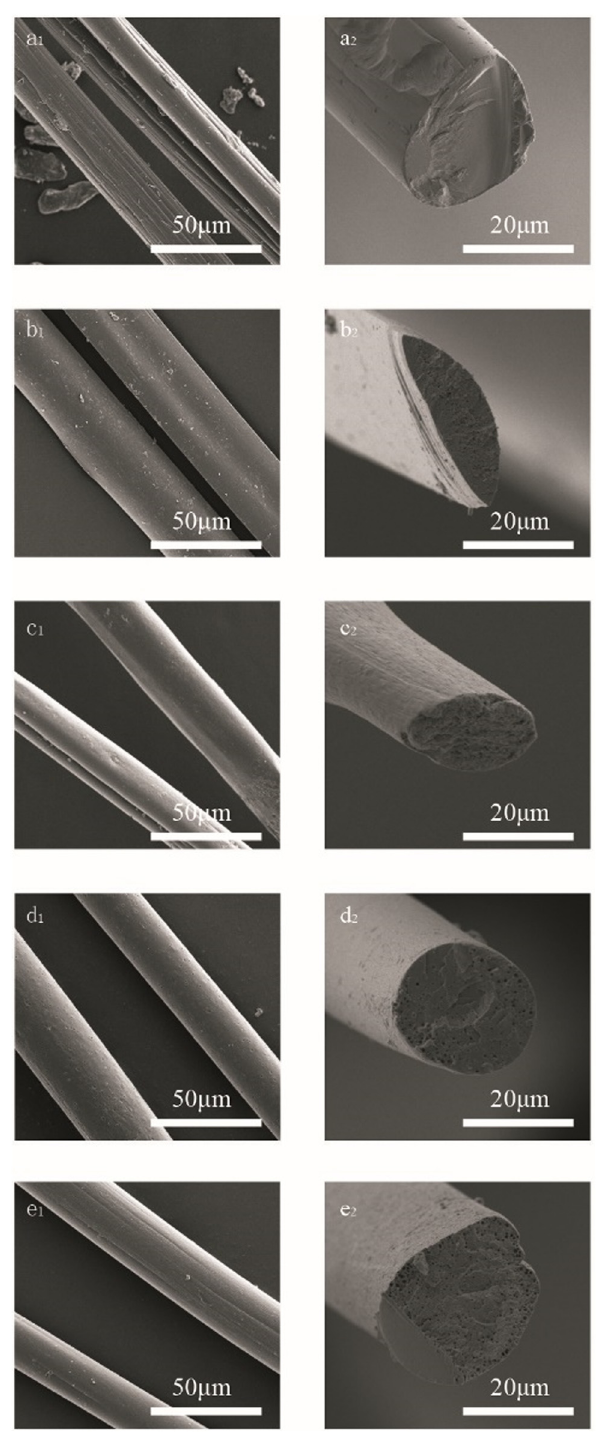
Figure 8: SEM images of the NF ( a 1 , a 2 ) , SC fi ber ( b 1 , b 2 ) , STC fi ber ( c ) , MC fi ber ( d ) , and MTC fi ber ( e 1 , c 2 1 , d 2 and cross - sections, respectively.